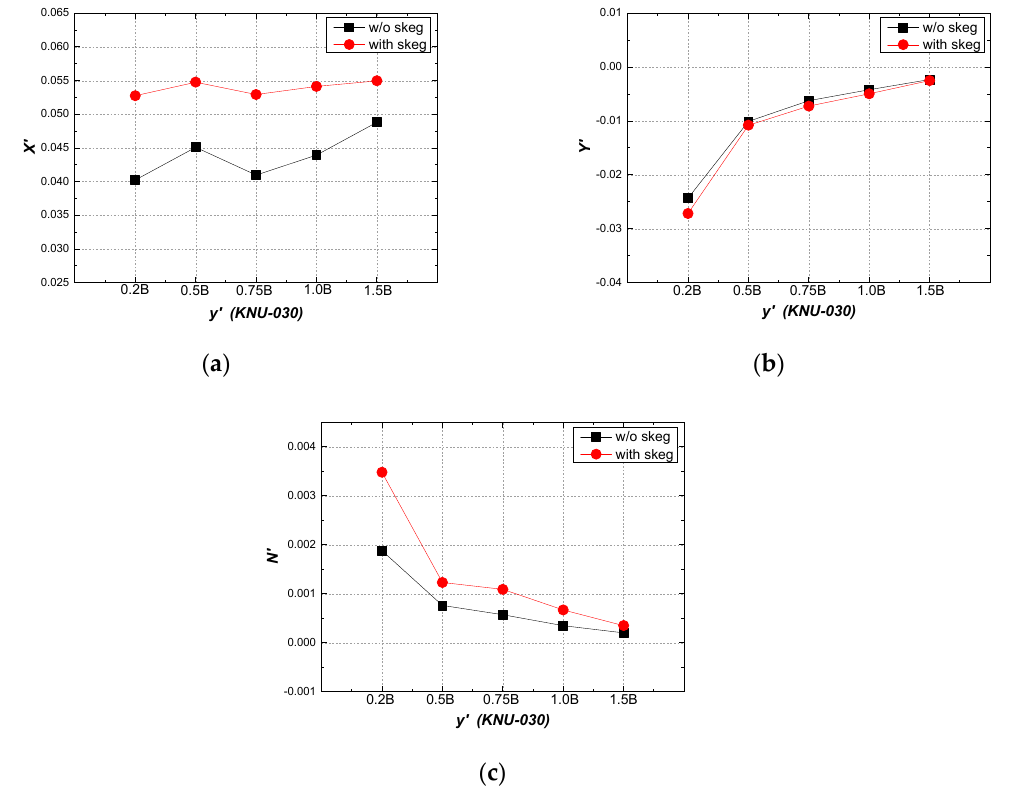
Figure 5. ( a ) Dimensionless surge force X’ , ( b ) sway force Y’ and ( c ) yaw moment N’ on KNU-030, according to the barge–bank distance.